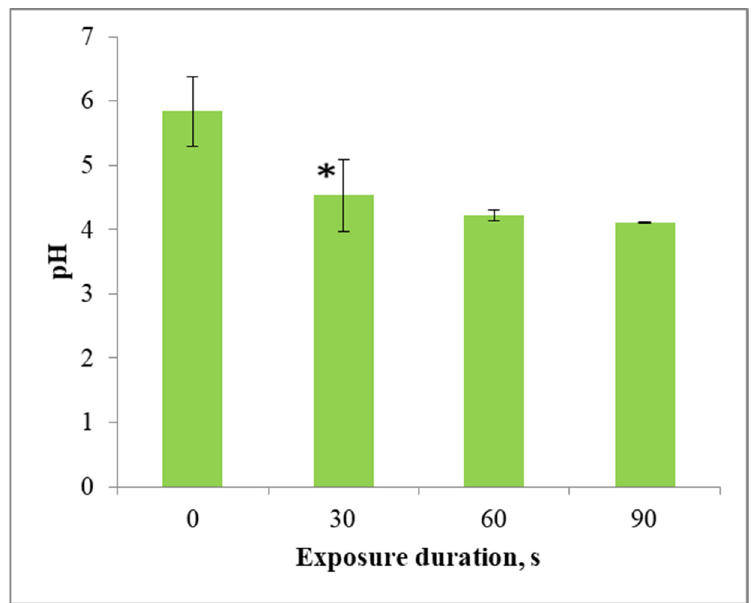
Figure 5. Dependence of nitrate concentration in the physiological solution on the time of pro- cessing by direct piezodischarge. The distance between the piezotransformer and the solution surface was 0.5 mm. The temperature of the surrounding medium was 20 ± 2 °C, and the air hu- midity was 70 ± 3%. In detail, the experimental conditions are described in the Section 2. The concentration of HOCl in the studied solutions weakly depends on the pro- cessing time and does not exceed 5 µM. Neutral pH decreases to 4.53 already after 30 s of treatment and then remains at this value (Figure 6). A nonlinear decrease in pH indicates that the production of new compounds in the solution improves its buffer properties.